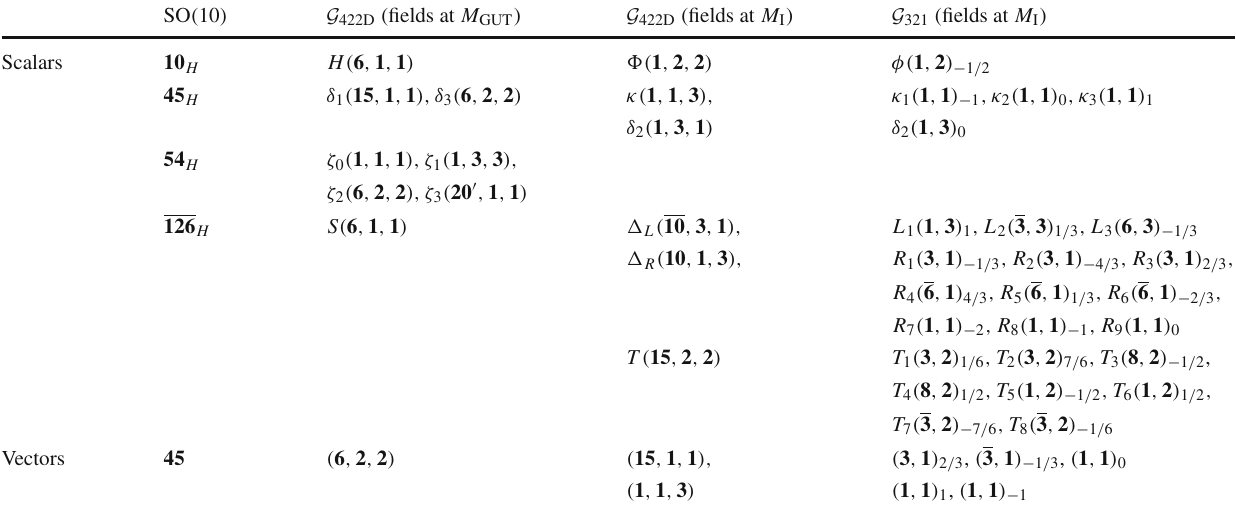
Table 5 Scalar and vector fields that have masses around M GUT and M I in the G 422D model SO ( 10 )